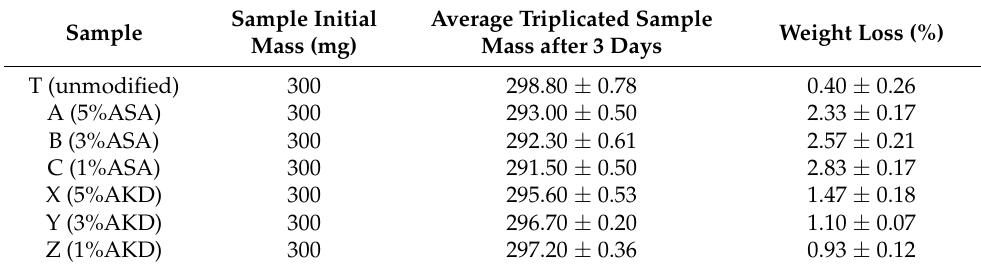
Table 2. Weight loss analysis of surface-modified rutile-TiO 2 NPs under thermal